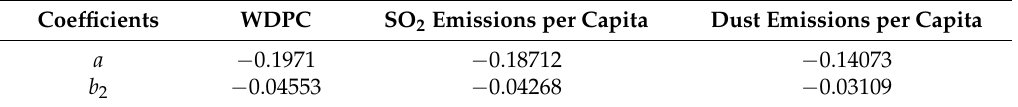
Table 2. The coefficients of GM (1, N ) for three